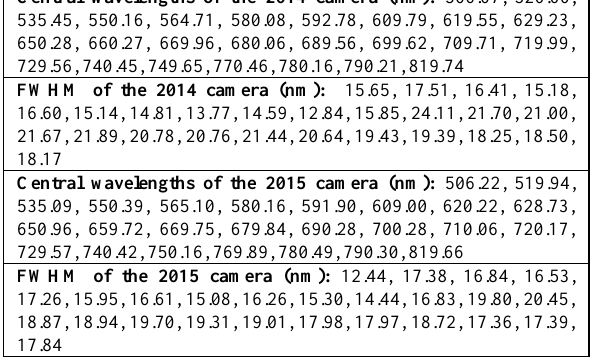
Table 1. Spectral settings of the FPI cameras